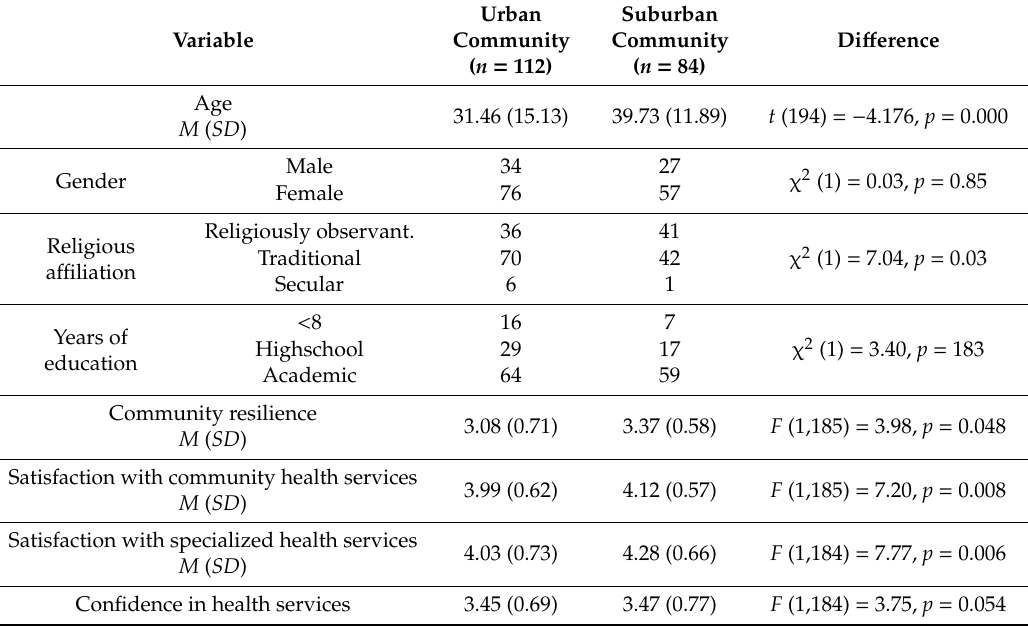
Table 1. Di ff erences in urban and suburban communities in study